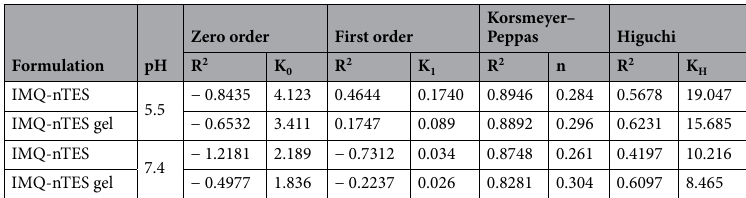
Table 4. Release kinetics modeling of IMQ-nTES and IMQ-nTES gel.